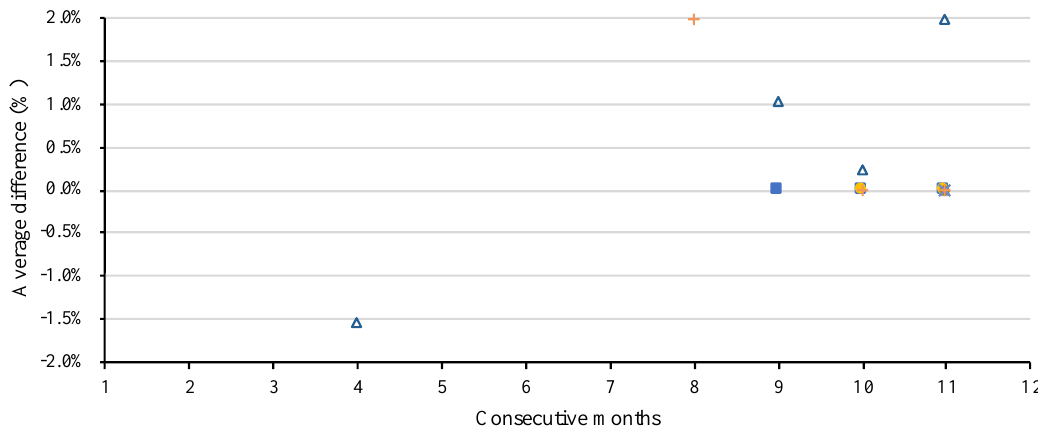
Figure 6. Heating balance-point temperature differences (%) from the baseline coefficient.